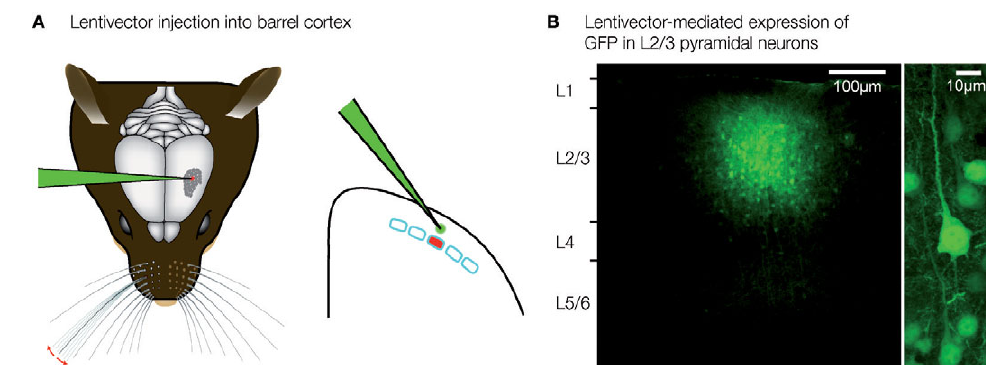
Figure 2 | Layer and cell-type specifi c genetic manipulation of the barrel cortex. (A) Lentivirus can be injected directly into the mouse barrel cortex using very fi ne glass micropipettes. (B) Lentivector injections result in highly localized gene transduction, limited to ∼ 200 µm around the injection site. Injection of GFP-expressing lentivector into layer 2/3, therefore results in highly specifi c GFP expression in layer 2/3 and not elsewhere (left). GFP expression in pyramidal neurons is driven by the α CaMKII promoter (right). Modifi ed and reproduced with permission from Aronoff and Petersen (2007). Frontiers in Integrative Neuroscience